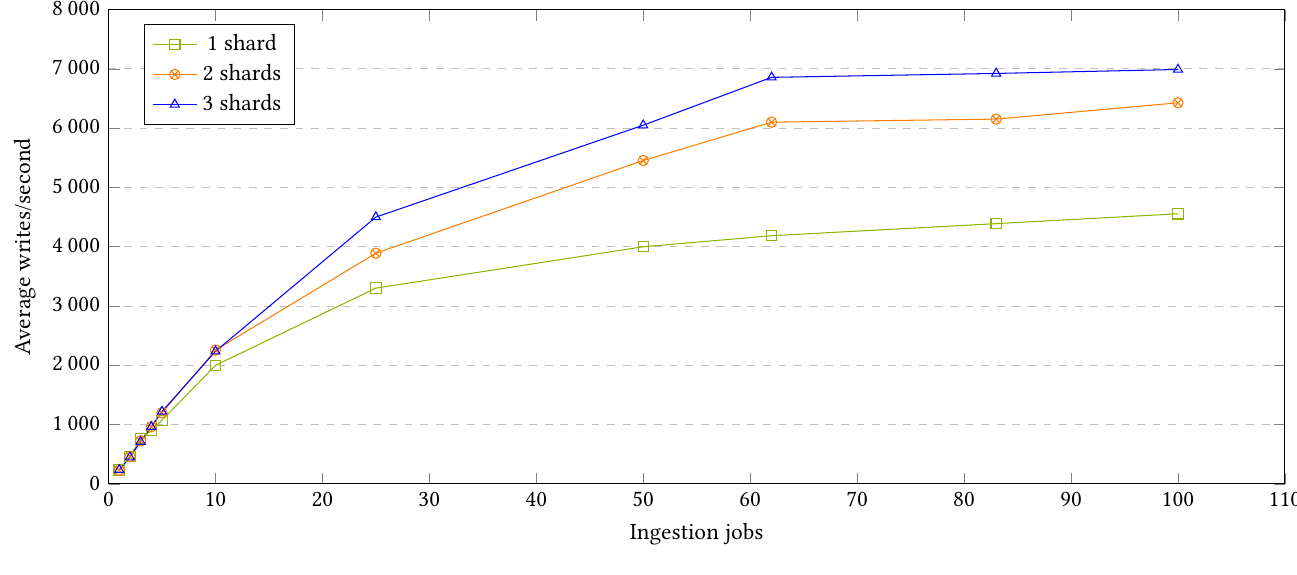
Figure 12. Evolution of the performance, in terms of triplet writes/second, from one to 100 parallel Figure 7: Scalability of the proposed approach with one to ingestion or shipping jobs and from one to three ingestion three ingestion nodes, for set ups of 2 as column length.